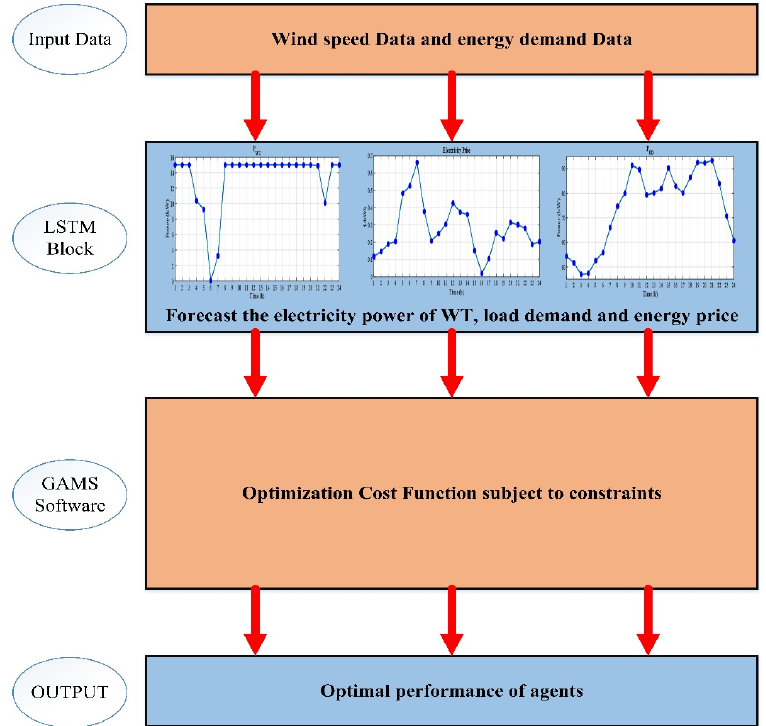
Figure 3. The overall structure of the proposed method.